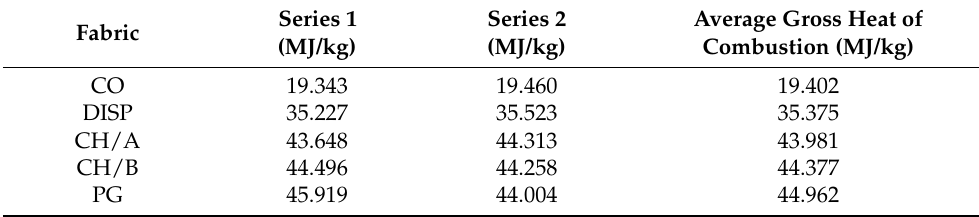
Table 4. The values of gross heat of combustion of fabrics.